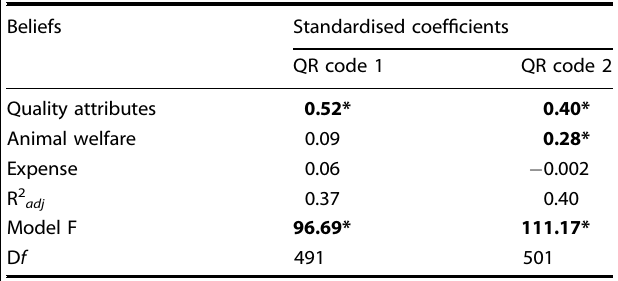
Fig. 2 Final regression model showing the exploratory factors in fl uencing intention to purchase QR code labelled pork. a QR code one (antibiotic usage label). b QR code two (farm assurance label). Table 5. Standardised regression coef fi cients (ß) for behavioural beliefs from regression analysis predicting consumers ’ attitude of QR code labelled pork for each sub-group (QR code one and QR code